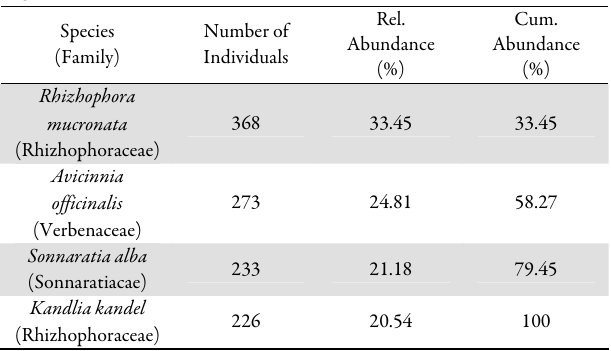
Tab. 1. Abundances of different species in the Kagekanu permanent vegetation plot